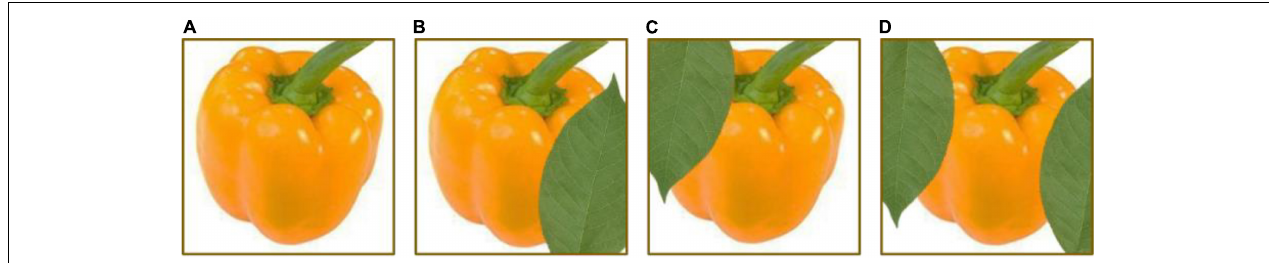
FIGURE 15 | Possible types of fruit in one scene formulated by Rehman and Miura (2021). (A) Center, (B) left, (C) right, and (D) occluded.